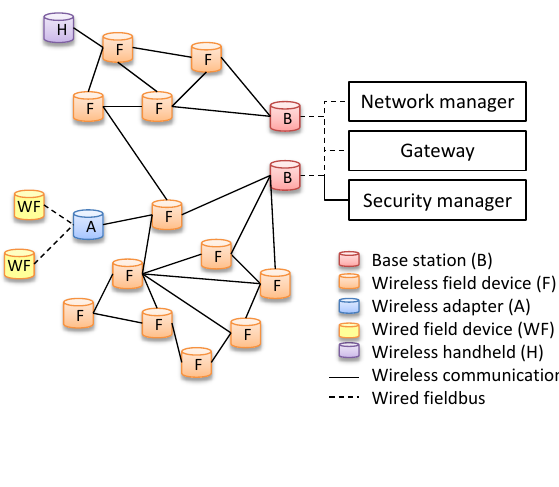
Figure 4. WirelessHART network elements